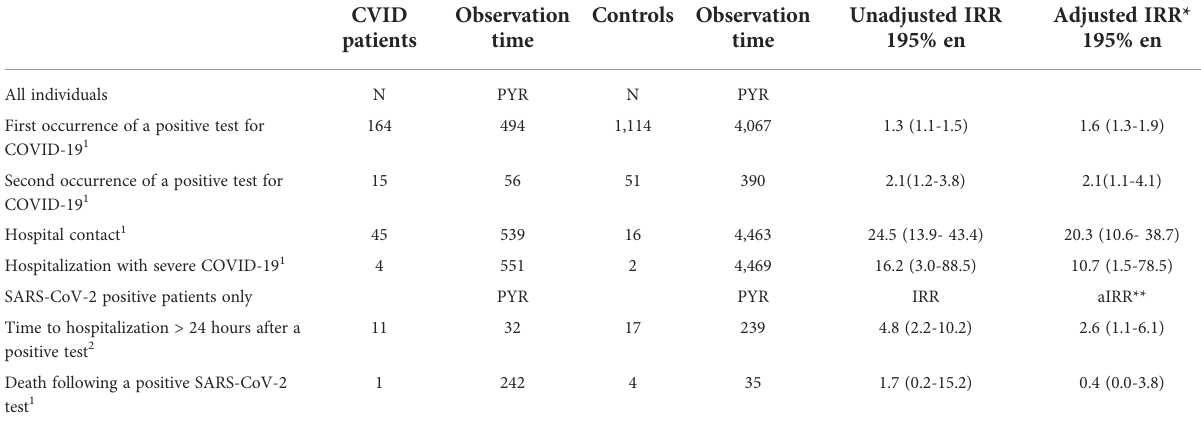
TABLE 2 Risk of fi rst positive SARS-CoV-2 test, vaccination, hospitalization and death in CVID patients vs. population controls in Denmark, March 1, 2020 – May 1, 2022.